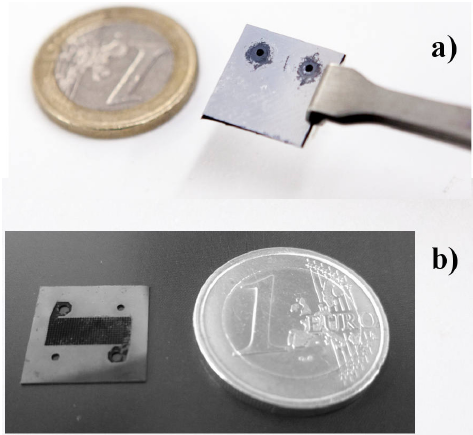
Figure 7. Photograph of a serial flow stack ( a ) and a parallel flow silicon bipolar plate ( b ) removed from a stack. Both photographs were taken after characterization. The 1 EUR coin is for size